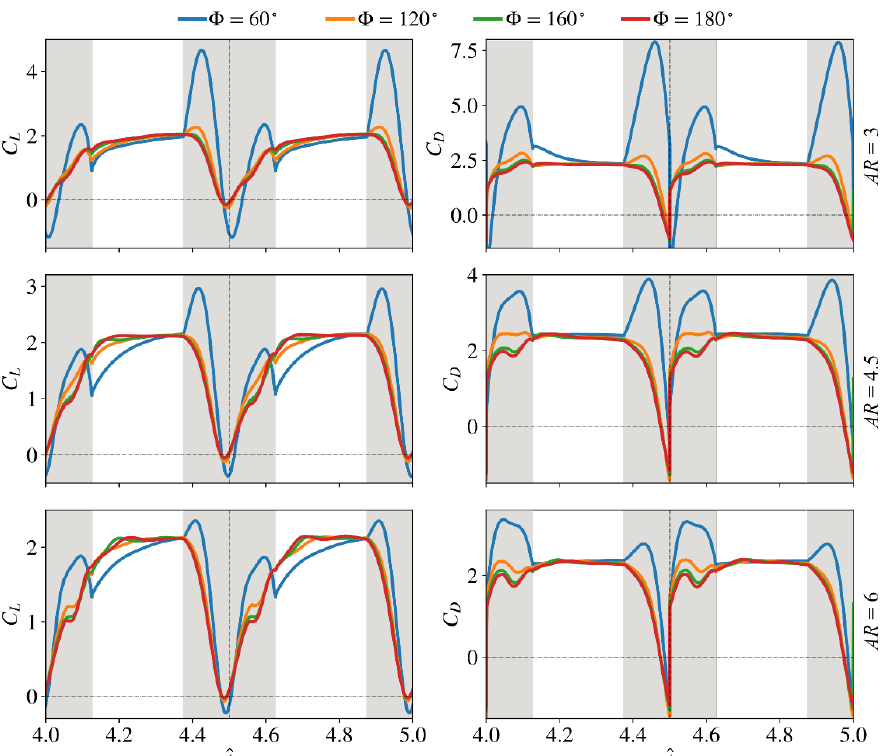
Figure 7. Variations of the instantaneous lift and drag coefficients for the different stroke amplitude and aspect ratio cases. The dimensionless radial centroid location is fixed to 0.5. Wing translational phases are indicated by white shading; wing rotational phases are indicated by grey shading.